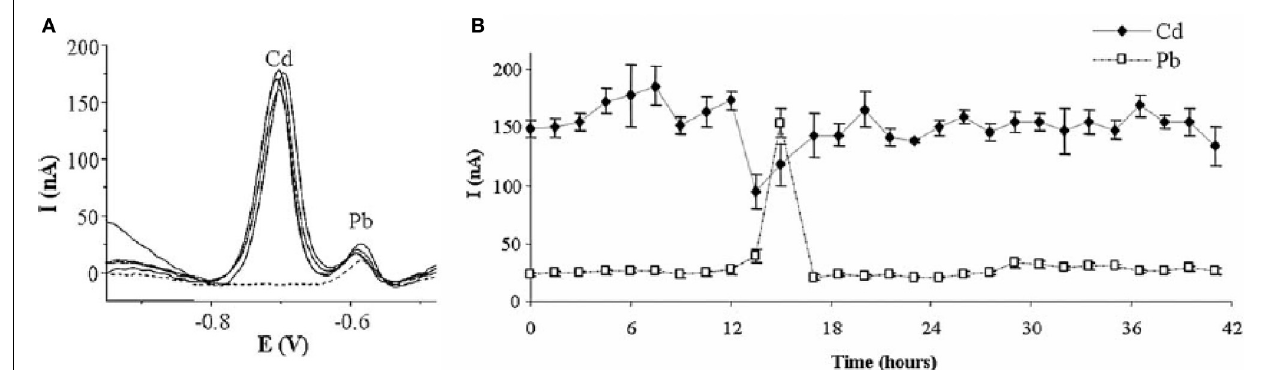
FIGURE 5 | (A) SW Voltammogram recorded every 12h for 42h analysis by semicontinuous flow injection of tap water doped with Cd (B) Variation of Cd and Pb peak currents over the 42h. Reprinted with permission from Betelu et al. (2007). Copyright 2007 Wiley-VCH.